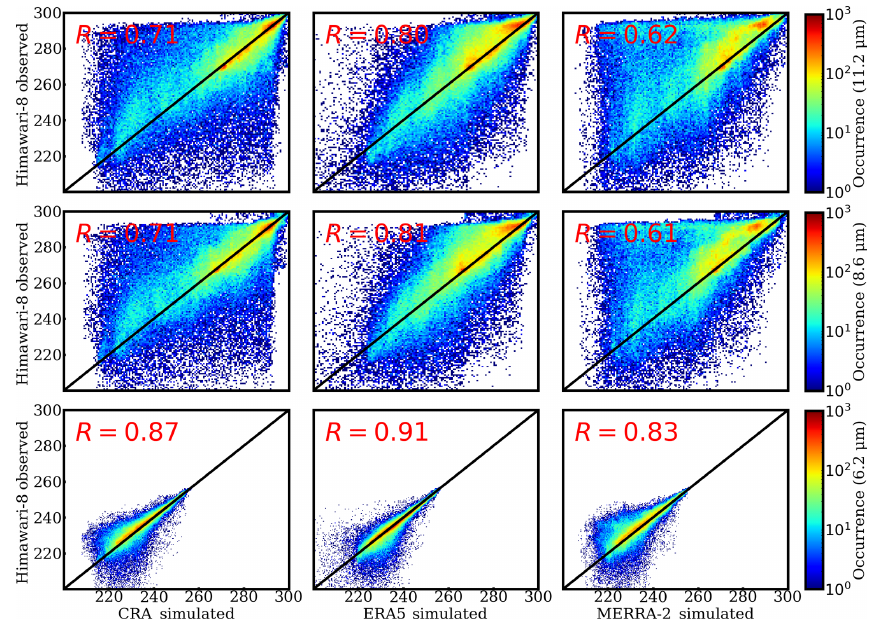
Figure 4. Same as the results in Fig. 2 but for the infrared